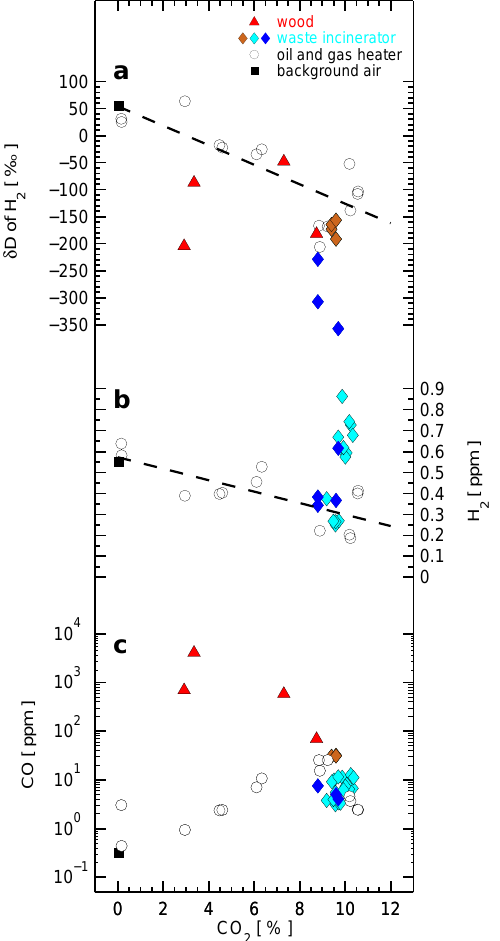
Fig. 2. Molecular hydrogen (H 2 ) isotopic composition ( δ D, a ), H 2 (b) and carbon monoxide (CO, c ) mole fractions versus car- bon dioxide (CO 2 ) from residential heating combustion and waste incinerator plants. Not all waste incinerator measurements appear in all three subplots because they were either not measured or ex- ceed the plotting range. Blue diamonds are for waste incinerator I-1, those in orange are for I-2, and those in cyan are from a later measurement campaign when no isotope measurements were con- ducted (I-3 to I-9). Samples with H 2 mole fractions > 1ppm (S7– S9, I-2, I-4A, I-5, I-8C) are omitted from (b) to better show the variability of the oil and gas heater measurements. The dashed lines are linear fits through the oil and gas heater measurements, exclud- ing S-7. These fits are δ D = − 18 . 052 × CO 2 + 54 . 305 for (a) and H 2 = − 0 . 0274 × CO 2 + 0 . 5729 for (b) and their respective